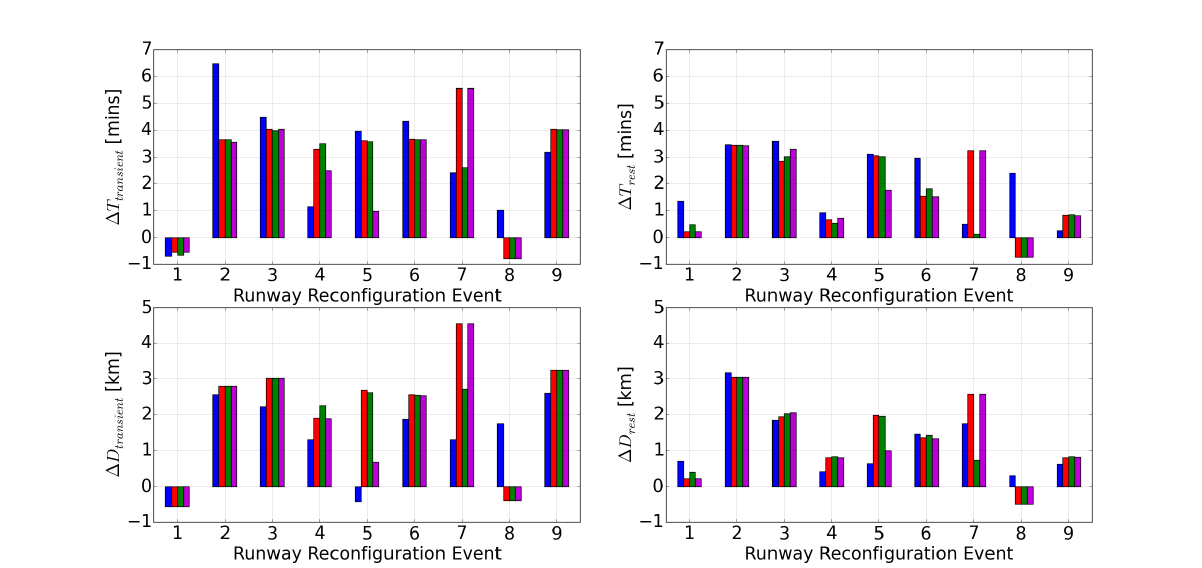
Figure 10. Deviations in the transient and rest phases for the considered runway reconfigurations of 2 May 2016. Blue bar: real-world performance, red bar: CBS mechanism performance, green bar: CBS + MP HWYs mechanism performance, purple bar: CBS + CB HWYs mechanism